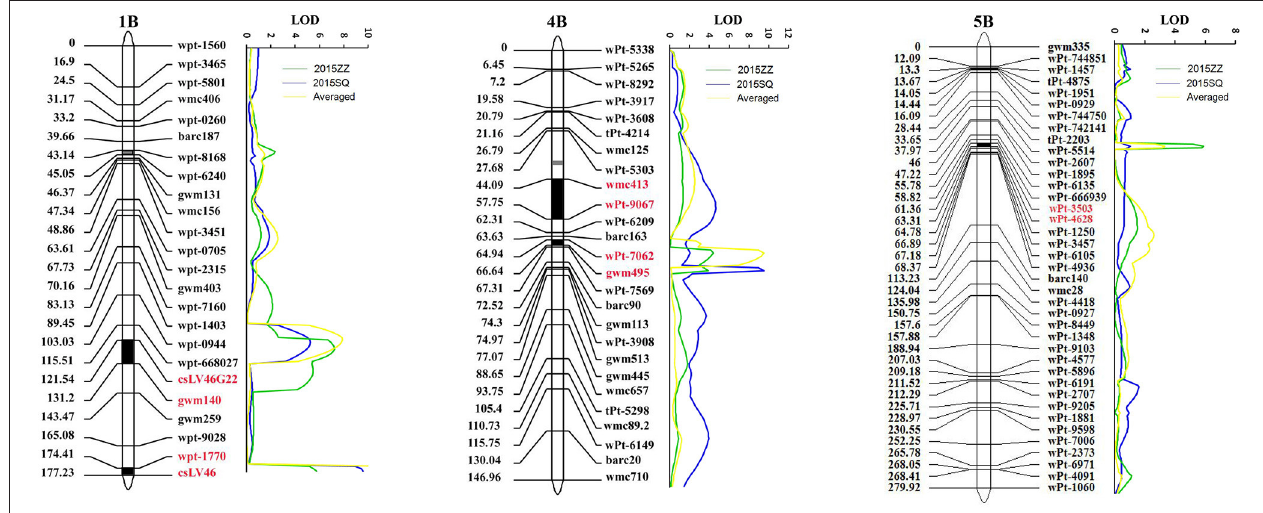
FIGURE 2 | LOD contours for QTL to powdery mildew on chromosomes 1B, 4B, and 5B in the wheat nested association mapping (NAM) population by Joint inclusive composite interval mapping (JICIM).